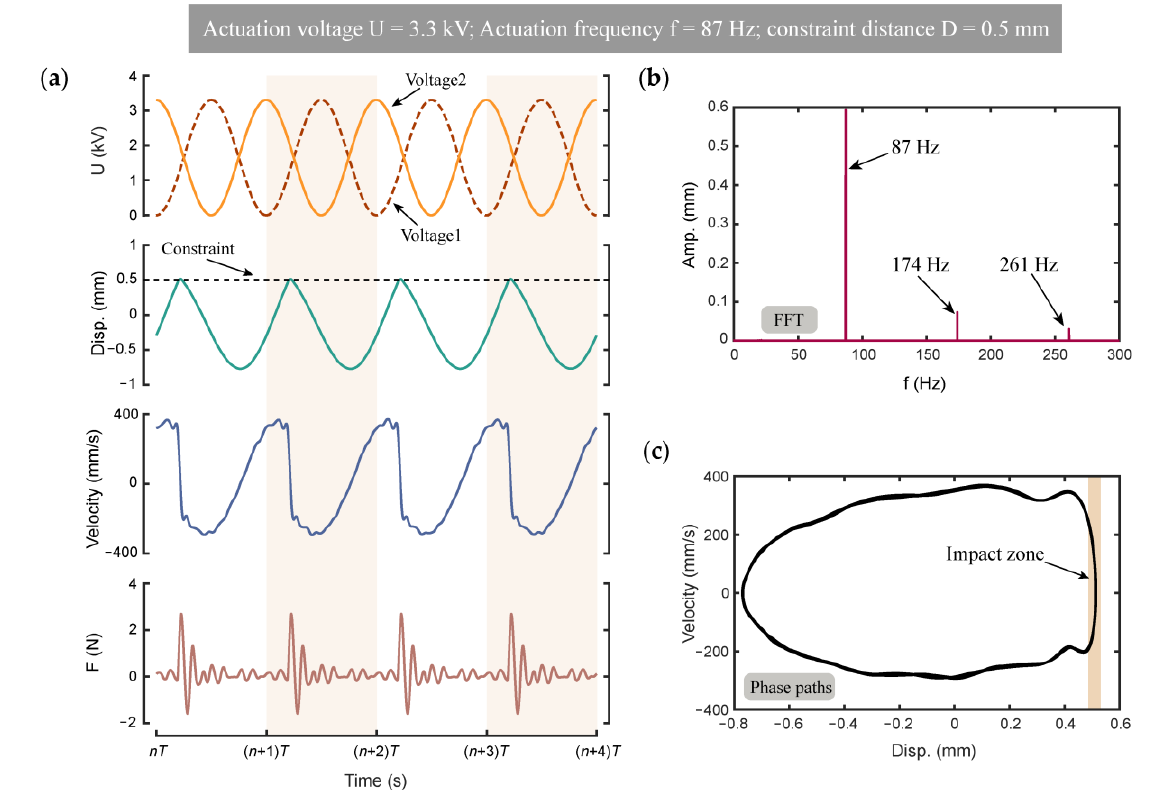
Figure 4. ( a ) DCDEA dynamic response results when the actuation voltage amplitude is 3.3 kV, the actuation frequency is 87 Hz, and the constraint gap is 0.5 mm; ( b ) Fast Fourier Transform (FFT) of the DCDEA oscillation displacement; ( c ) Phase paths diagram of the DCDEA.